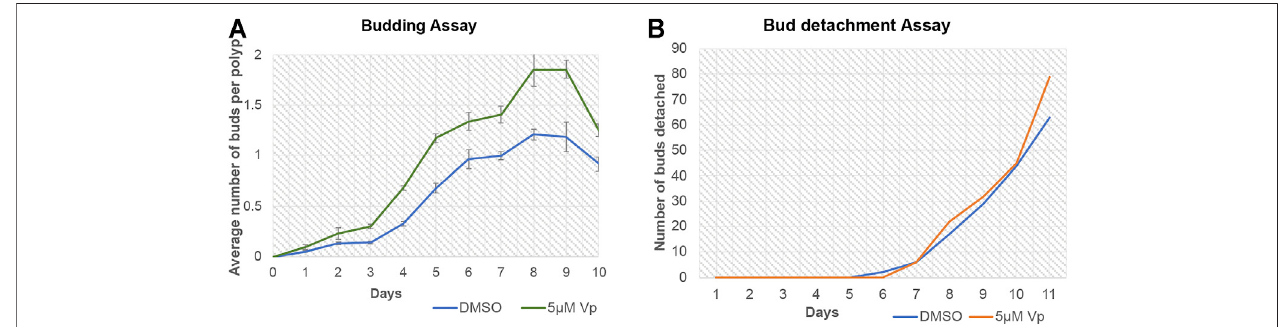
FIGURE 9 | Disruption of YAP-TEAD interaction in Hydra leads to an increase in budding kinetics. The YAP-TEAD interaction in Hydra was targeted using vertepor fi n (Vp) and the budding rate of the polyps were assayed against DMSO treated control polyps by calculating average buds per Hydra for the period of 10 days post treatment. (A) Vp treatment (5 µM) led to signi fi cant increase in the budding rate in Vp treated polyps as compared to the DMSO treated control polyps from day 3 – 10(Refer SupplementaryTableS2 forstatisticaldata).48polypswerescoredpersetperexperimentandtotalofthreebiologicalreplicateswereperformedfor each set. (B) Bud detachment assay was performed by calculating cumulative buds detached on each day. This experiment showed no change isVp vs DMSO treated polyps indicating that increased budding rate is a function of cell proliferation and not bud detachment rate.